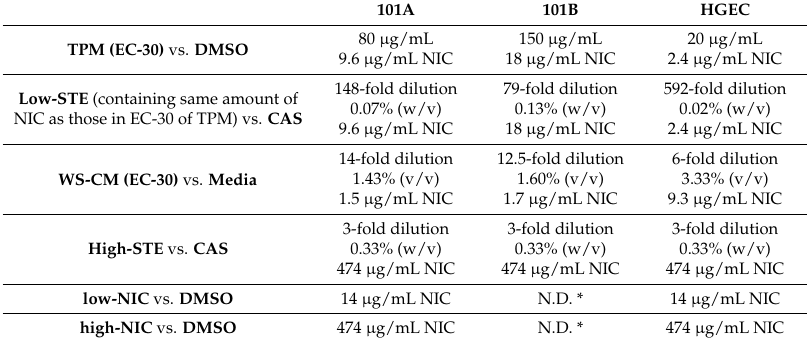
Table 1. Treatment conditions for microarray gene expression profiling samples. Target cells were exposed for 24 h to different tobacco product preparations (TPPs) or solvent only as controls. For total particulate matter (TPM) and whole-smoke conditioned media (WS-CM), effective concentration for 30% of maximal effect (EC-30) doses were applied; for smokeless tobacco extract in complete artificial saliva (STE/CAS), the dose with the same amount of nicotine (NIC) as that in TPM at EC-30 was applied. Also, treatment with a high dose of NIC was done. For each condition, the dilution factors and NIC equivalents delivered are listed.